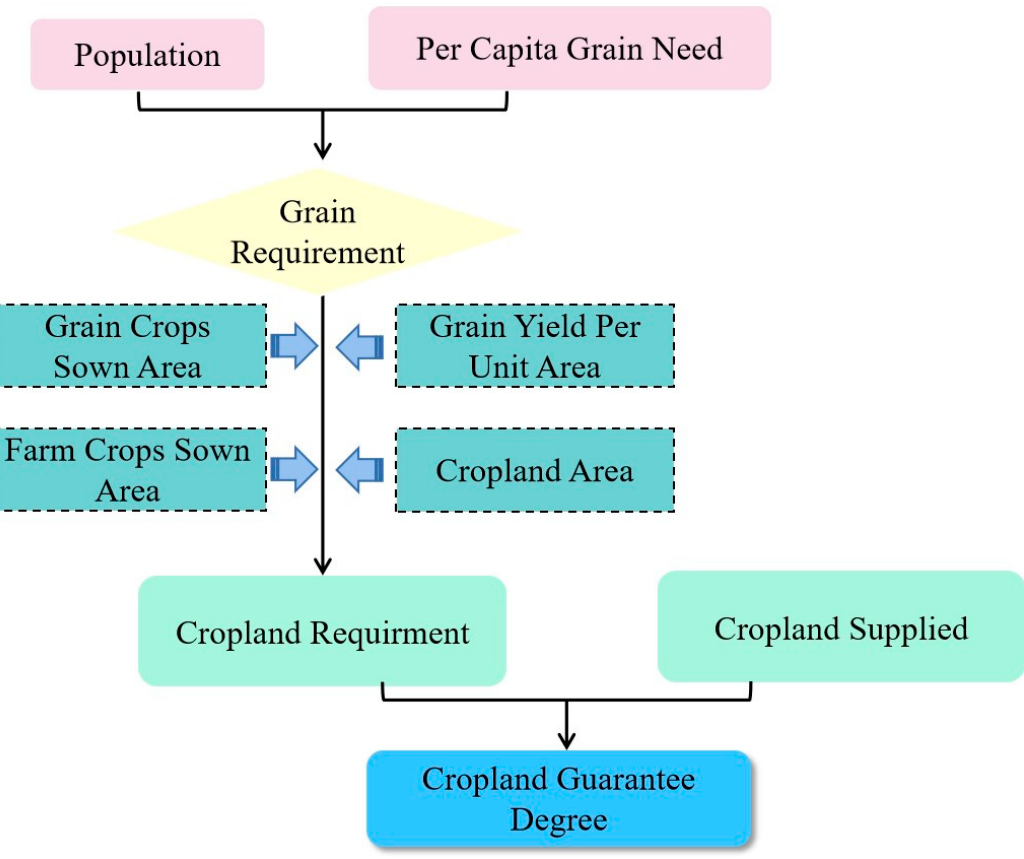
Figure 1. Technical flow chart of this study.